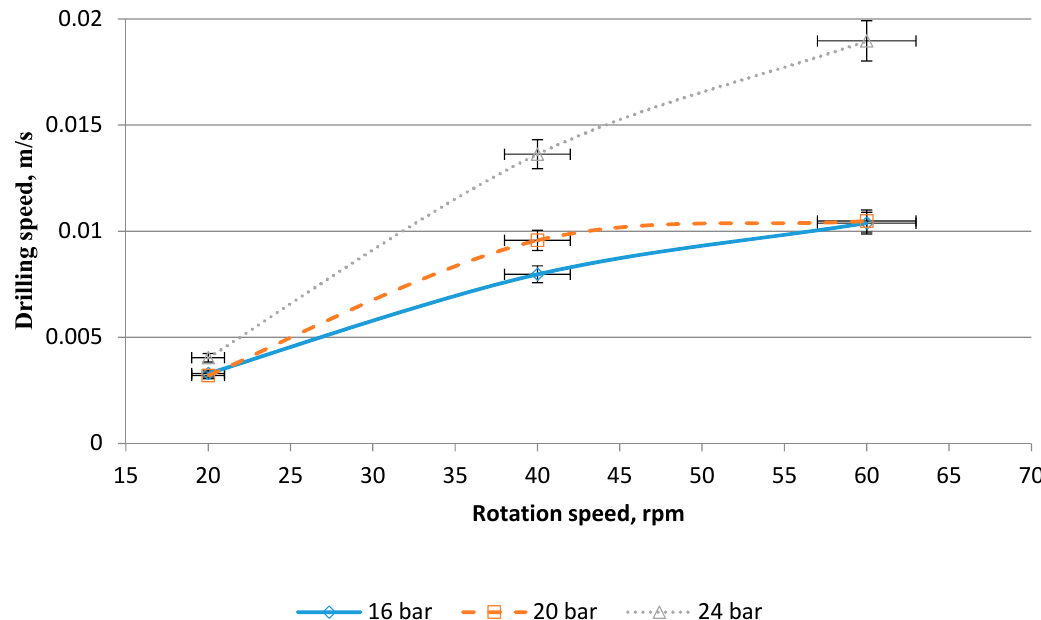
Figure 9. Variation of drilling velocity with rotation speed for several pressures (shown in the legend below the figure), for the 127 mm diameter drill bit, an interval of 72 to 90 m below the ground level, and boreholes 4–6.